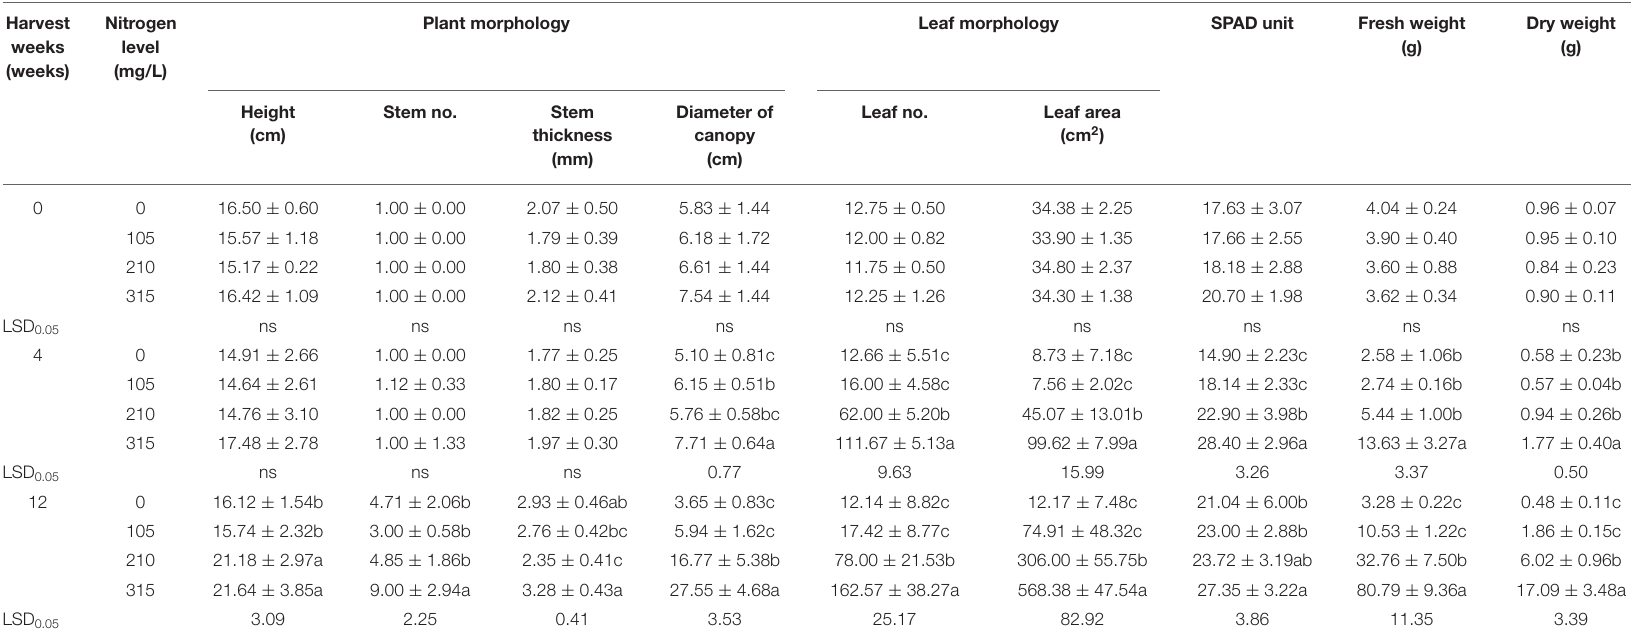
TABLE 2 | Physiological changes of potted Mentha arvensis grown in the evaporative greenhouse system with different nitrogen